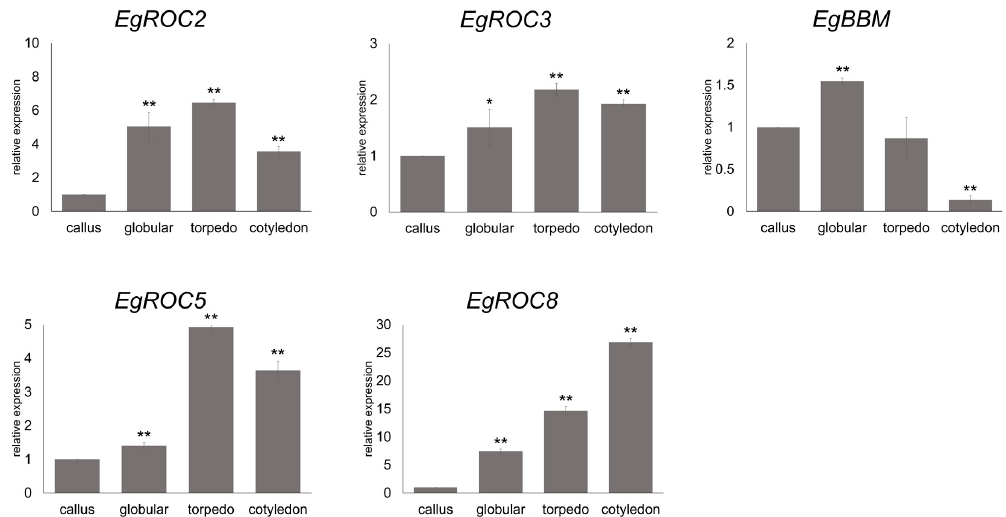
Figure 6. Validation of EgHD-ZIP IV and EgBBM gene expression during oil palm somatic embryo- genesis. The relative expression level of EgROC2 , EgROC3 , EgROC5 , EgROC8 , and EgBBM genes in callus, globular, torpedo, cotyledon, and plantlet stages were calculated using the 2 −ΔΔ Ct method and presented as mean ± SD of three biological replicates. Asterisks indicate a significant difference from the callus stage (Student’s t -test: *— p < 0.05; **— p < 0.01).